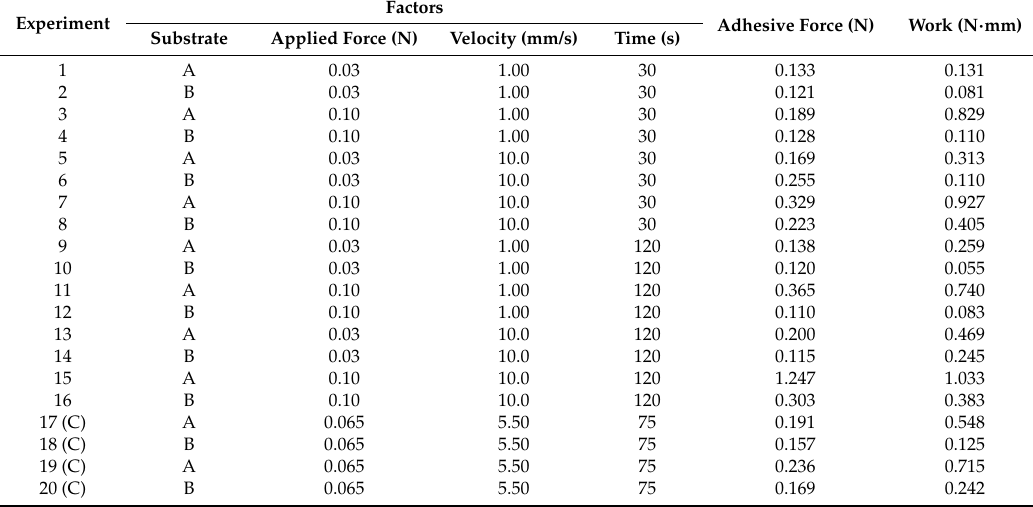
Table 3. Response values of the mucoadhesive force (N) and the work adhesion (N · mm) of the binary polymeric system containing 15% ( w / w ) P407 and 0.25% ( w / w ) PCB, at 37 ◦ C, using porcine mucin disks (A) or porcine oral mucosa (B). Each value represents the mean of at least three replicates. In all cases, the coefficient of variation of replicate analyses was less than